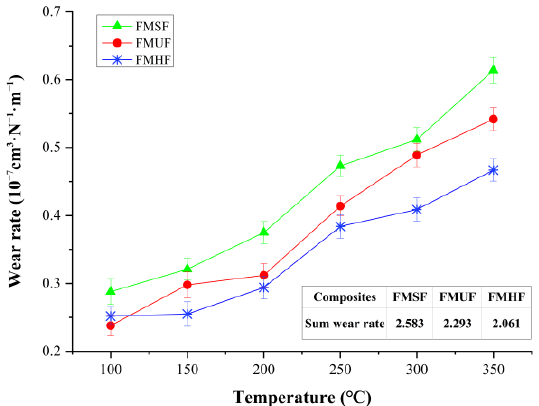
Figure 6. Wear performance of the developed composite